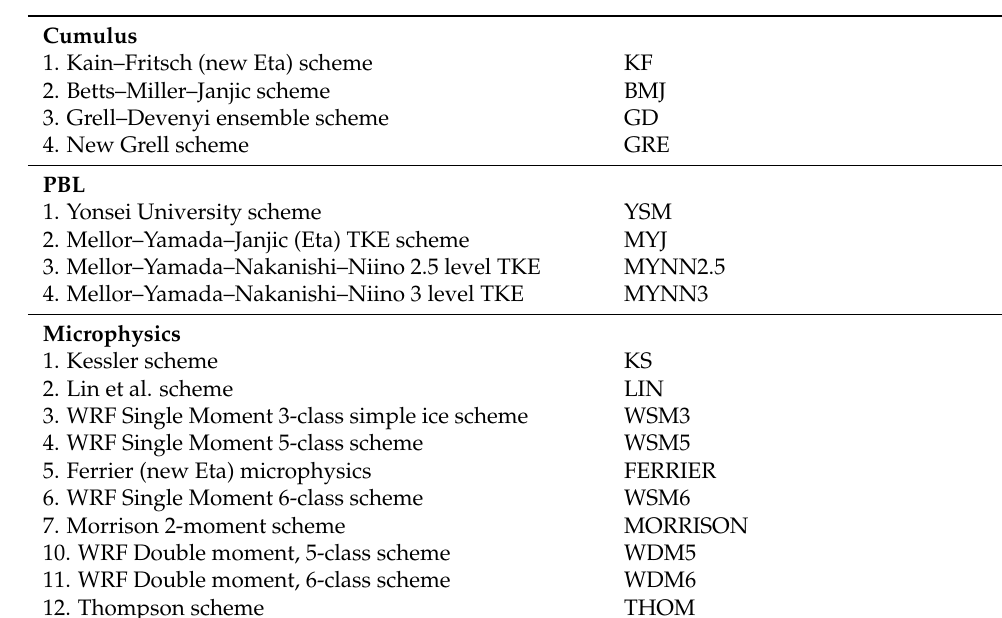
Table 1. Model physics parameterisation